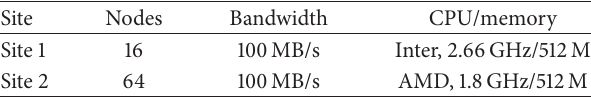
Table 1: Computing resources used in platform.